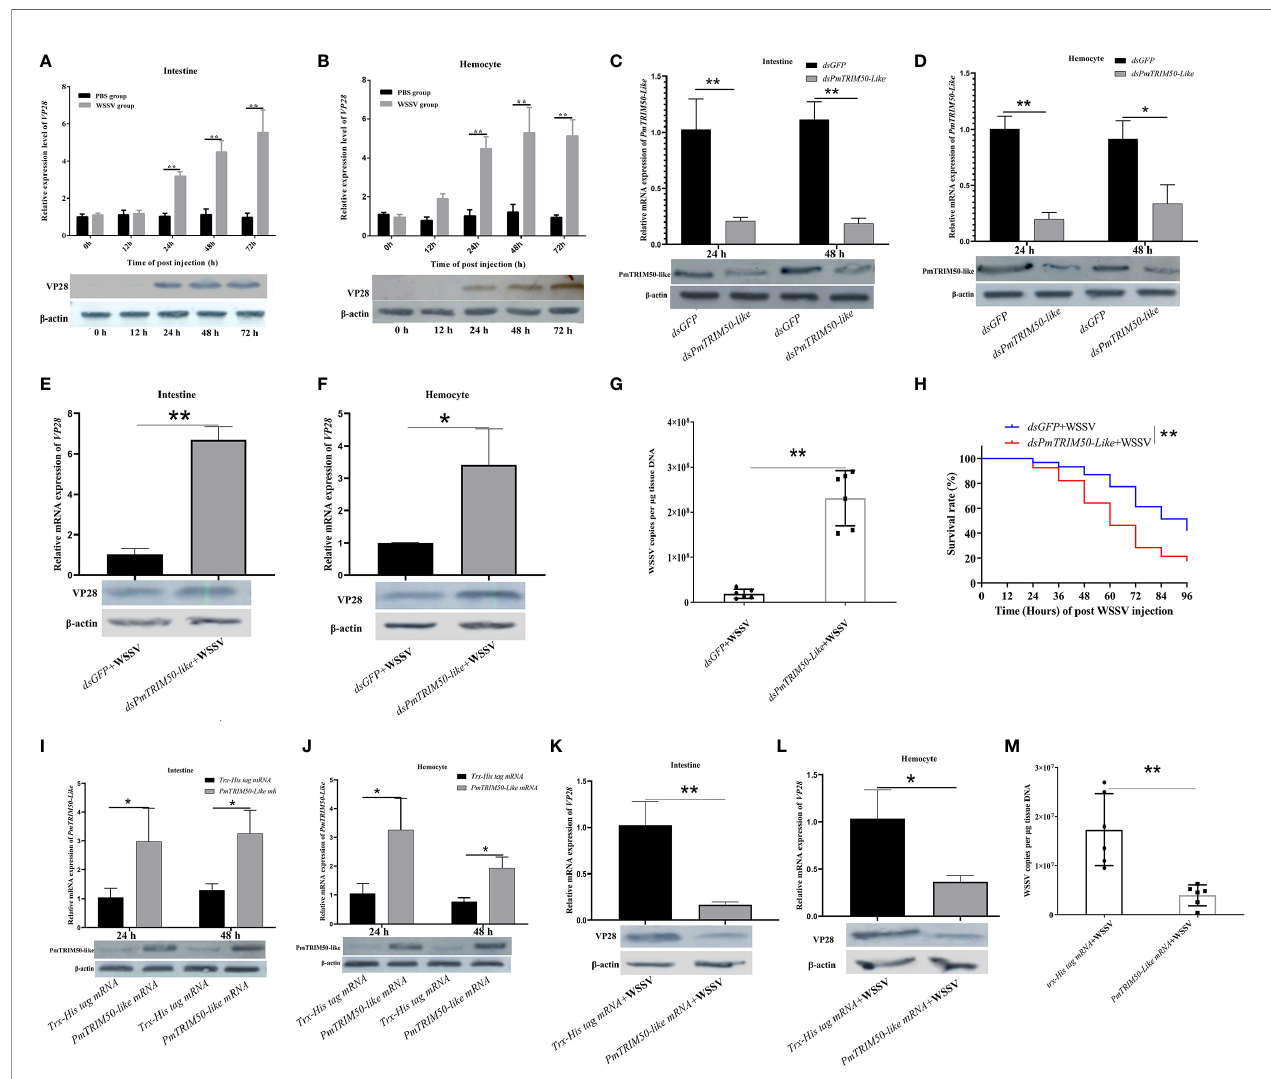
FIGURE 2 | PmTRIM50-like restricted WSSV infection in shrimp. (A, B) Expression patterns of VP28 mRNA and protein were detected by qRT-PCR (upper panel) and western blotting (lower panel) in intestine (A) and hemocyte (B) after WSSV challenge. (C) Ef fi ciency of dsPmTRIM50-like was detected by qRT-PCR (upper panel) and western blotting (lower panel) in the intestine. (D) Ef fi ciency of dsPmTRIM50-like was detected by qRT-PCR (upper panel) and western blotting (lower panel) in hemocytes. (E) Expression of VP28 in the intestine of dsPmTRIM50-like +WSSV group and dsGFP +WSSV group was determined by qRT-PCR (upper panel) and western blotting (lower panel). (F) Expression of VP28 in hemocytes of dsPmTRIM50-like +WSSV group and dsGFP +WSSV group was determined by qRT-PCR (upper panel) and western blotting (lower panel). (G) The copy number of WSSV in the intestine of dsPmTRIM50-like +WSSV group and dsGFP +WSSV group was detected by qPCR. (H) The survival rate in dsPmTRIM50-like +WSSV group and dsGFP +WSSV group was detected after challenged by WSSV. Survival rates were analyzed statistically using the Kaplan-Meier plots (log-rank X2). (I) Ef fi ciency of PmTRIM50-like overexpression was detected by qRT-PCR (upper panel) and western blotting (lower panel) in the intestine. (J) Ef fi ciency of PmTRIM50-like overexpression was detected by qRT-PCR (upper panel) and western blotting (lower panel) in hemocyte. (K) Expression of VP28 in the intestine of PmTRIM50-like mRNA+WSSV group and Trx-His tag mRNA+WSSV group was determined by qRT-PCR (upper panel) and western blotting (lower panel). (L) Expression of VP28 in hemocytes of PmTRIM50-like mRNA+WSSV group and Trx-His tag mRNA+ WSSV group was determined by qRT-PCR (upper panel) and western blotting (lower panel). (M) The copy number of WSSV in the intestine of PmTRIM50-like mRNA+WSSV group and Trx-His tag mRNA+WSSV group was detected by qPCR. The experiments were repeated three times. b -actin was used as an internal reference. Asterisks indicate signi fi cant differences * P< 0.05 and ** P <0.01